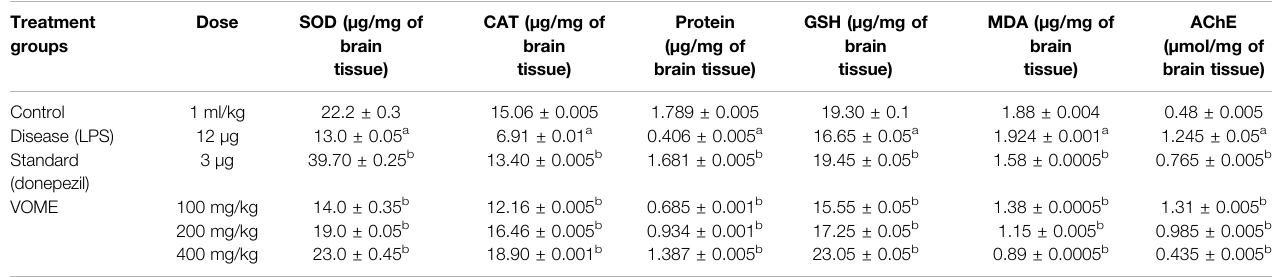
TABLE 2 | Effects of Viola odorata methanolic extract on oxidative stress biomarkers and acetylcholinesterase Treatment